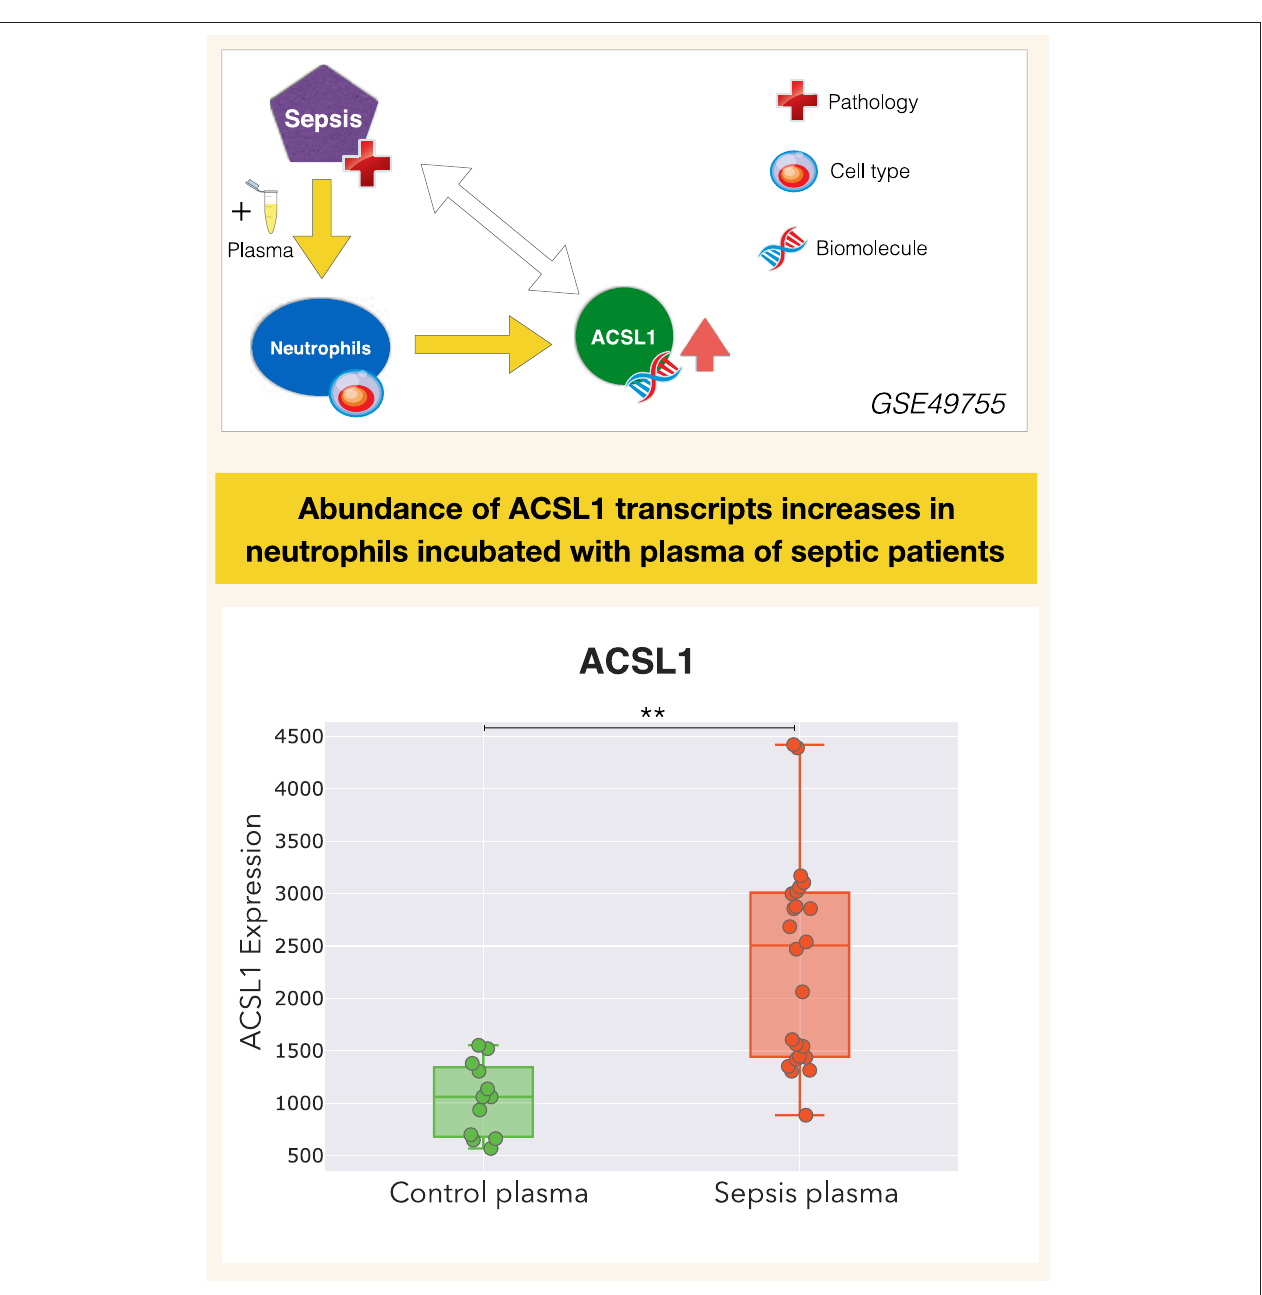
FIGURE 1 | ACSL1 is upregulated by septic plasma. Abundance of ACSL1 transcripts was measured by microarray in neutrophils exposed in vitro for 6h to plasma from uninfected control subjects or from patients with sepsis [from a dataset deposited in GEO by Khaenam et al. with unique identifier GSE49755 (7)]. Neutrophils were obtained from two different healthy donors, each exposed to the same set of plasma samples which consisted in plasma from 6 uninfected controls and 12 septic patients. Differences between groups were statistically significant (** p < 0.01), and confirmed in two independent test sets from the same study (GSE49756, GSE49757). ACSL1 profiles from all three datasets can be accessed via the GXB data browsing application: (8–10). Design elements in this and subsequent figures obtained from http://www.clker.com/ (eppendorf tube) and https://www.vecteezy.com (red cross, DNA helix,